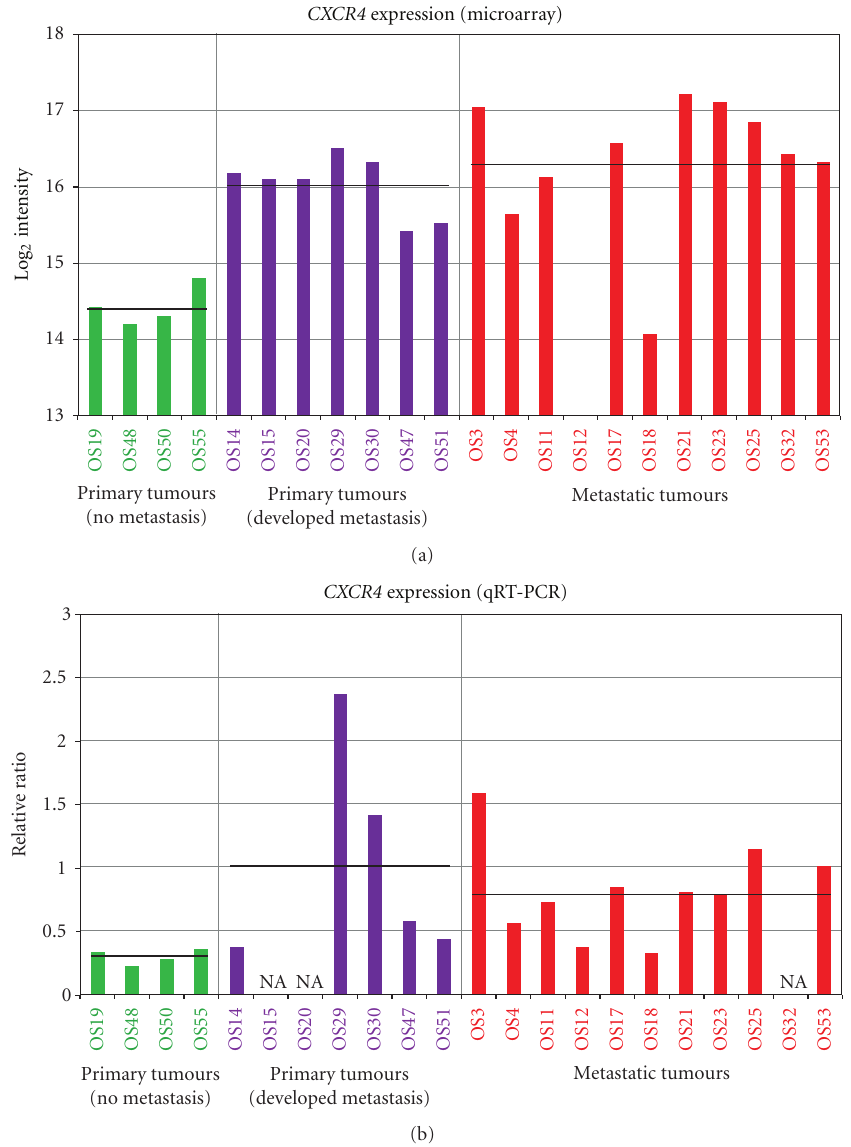
Figure 3: Relative CXCR4 expression in primary tumours from patients who did or did not develop metastases and in metastatic samples (one primary tumour with no clinical information on metastases was excluded) based on (a) microarray data and (b) quantitative real-time RT-PCR data. For the quantitative real-time RT-PCR data, the expression levels have been normalised to the average expression of three housekeeping genes ( 18S , B2M and TBP ) and compared to the average expression of two normal bone samples. The average expression level in each sample group is indicated with a black bar. NA, not